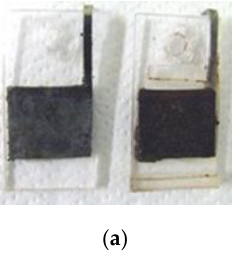
Figure A2. Images of vulcanized MCF rubber on anode by electrolytic polymerization: ( a ) stainless electrodes; ( b ) copper electrodes; right is the cathode and the left is the anode.